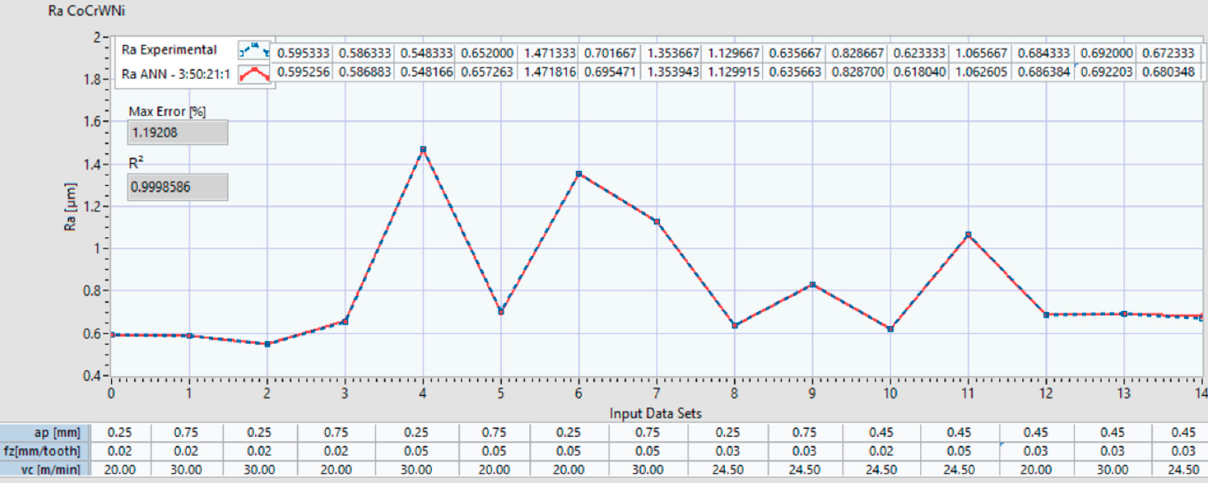
Figure 13. Ra comparison between experimental data and ANN predictions with architecture 3:50:21:1 for Co–20Cr– 15W–10Ni.